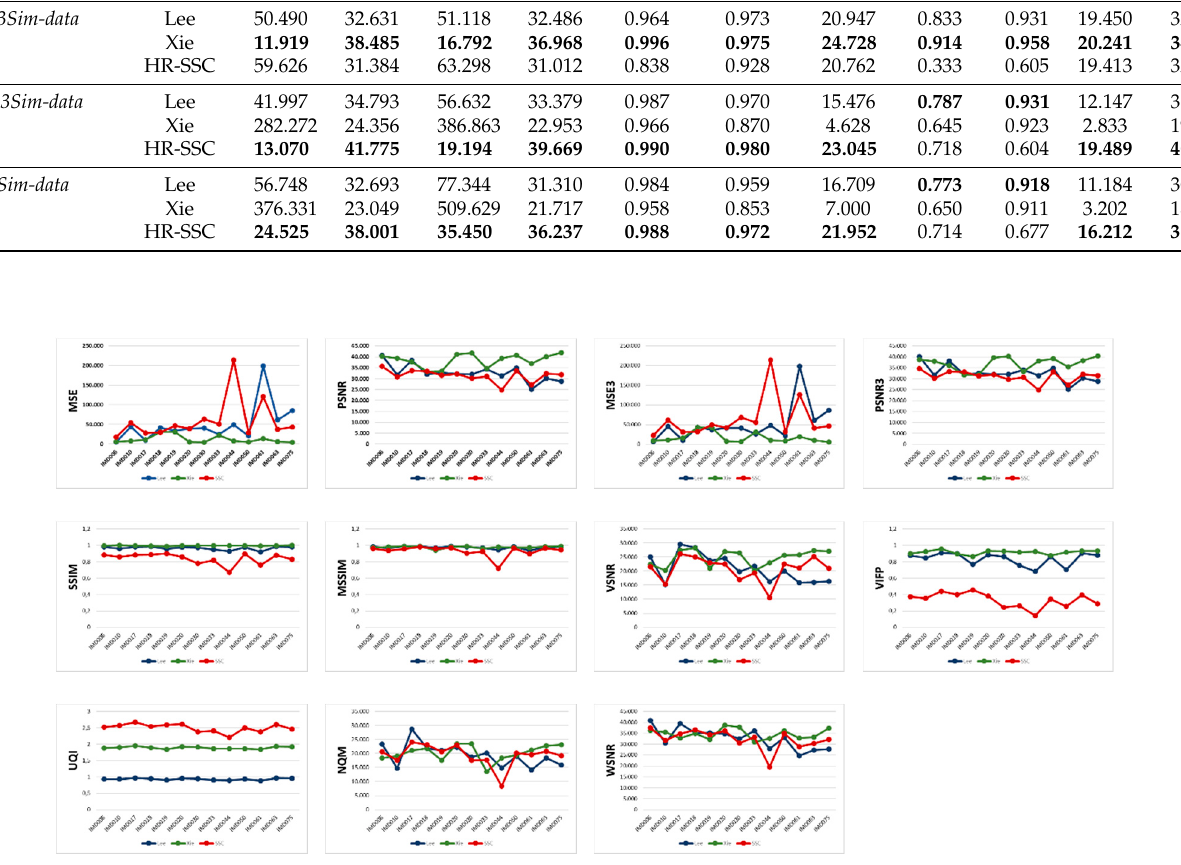
Figure 16. Trends of quality measures on H13Sim-data for the methods Lee, Xie, and HR-SSC.